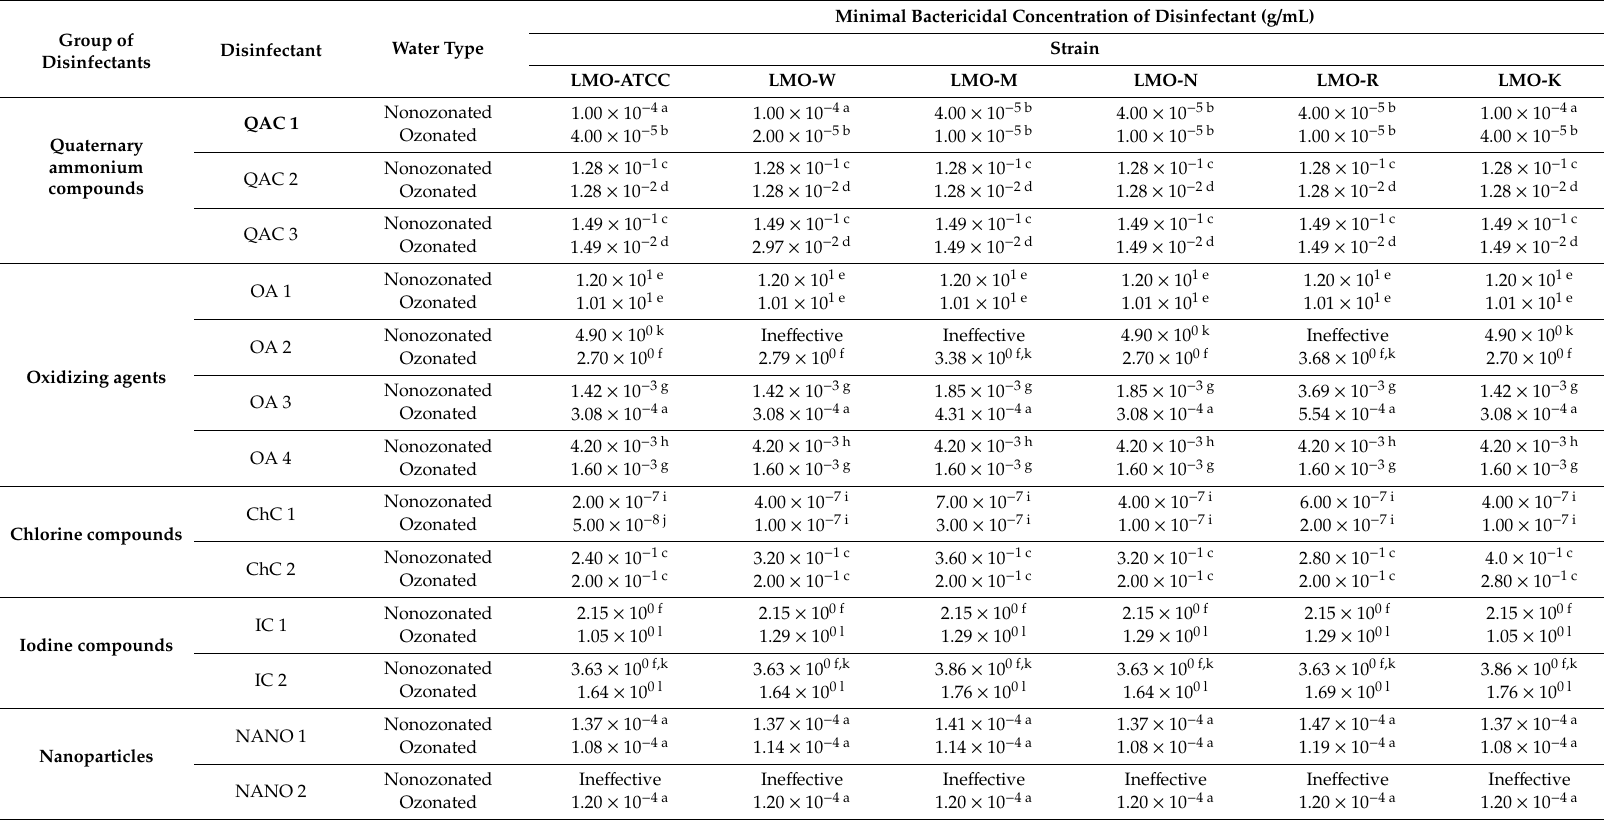
Table 3. Minimal bactericidal concentration of tested disinfectant depending of water type (g /